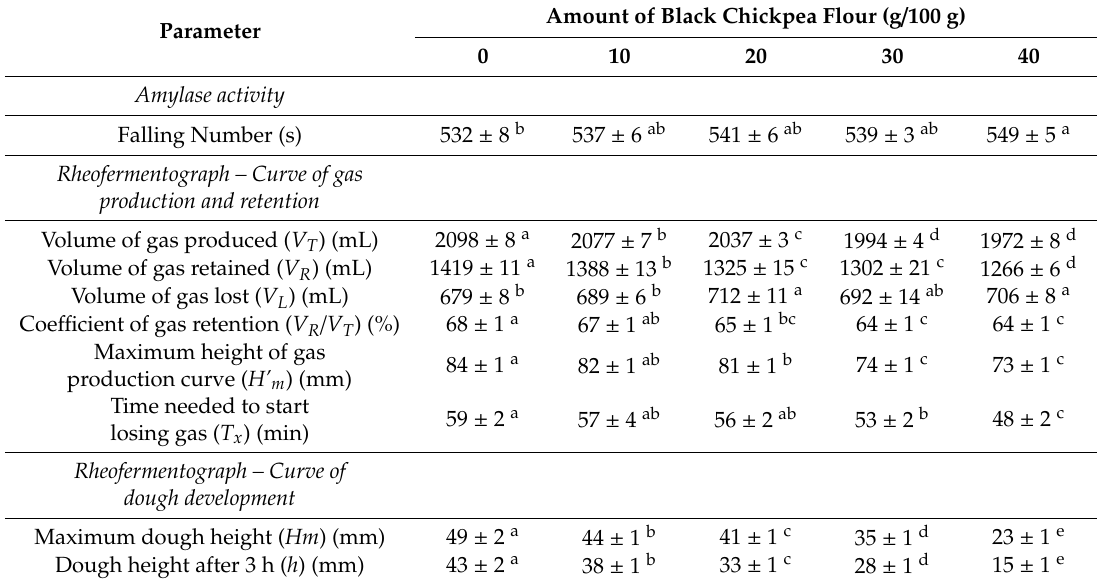
Table 4. The fermentative attitude of pure durum wheat re-milled semolina and of blends with increasing amounts of Apulian black chickpea wholemeal